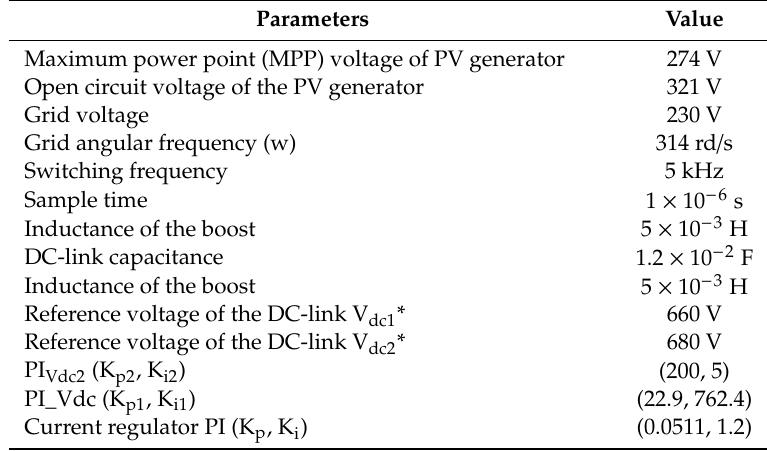
Table 1. Parameters of the system.